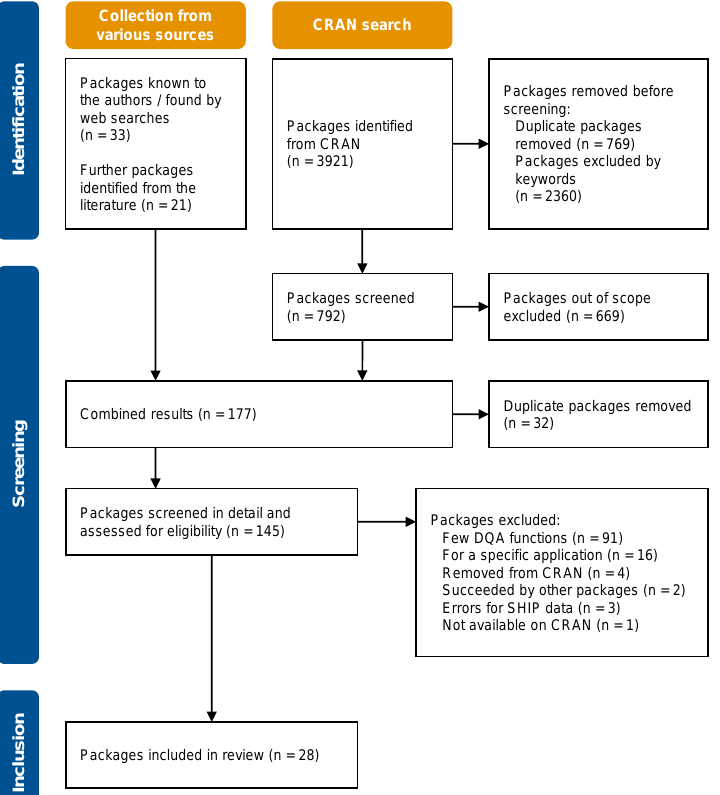
Figure 1. PRISMA flow diagram showing the number of packages considered during the three phases of our review process (Identification, Screening, and Inclusion). The Identification step comprises two independent starting points (collection from various sources and CRAN search) because we conducted two searches for packages in parallel. During the Screening phase, we combined the packages identified from both approaches. The main reason for excluding packages after screening was not meeting our inclusion criteria in the scope of functionalities for data quality assessments. In total, 28 packages remained at the end of the search, but we regard one of them ( errorlocate ) as an addition to another package ( validate ) and report their assessment